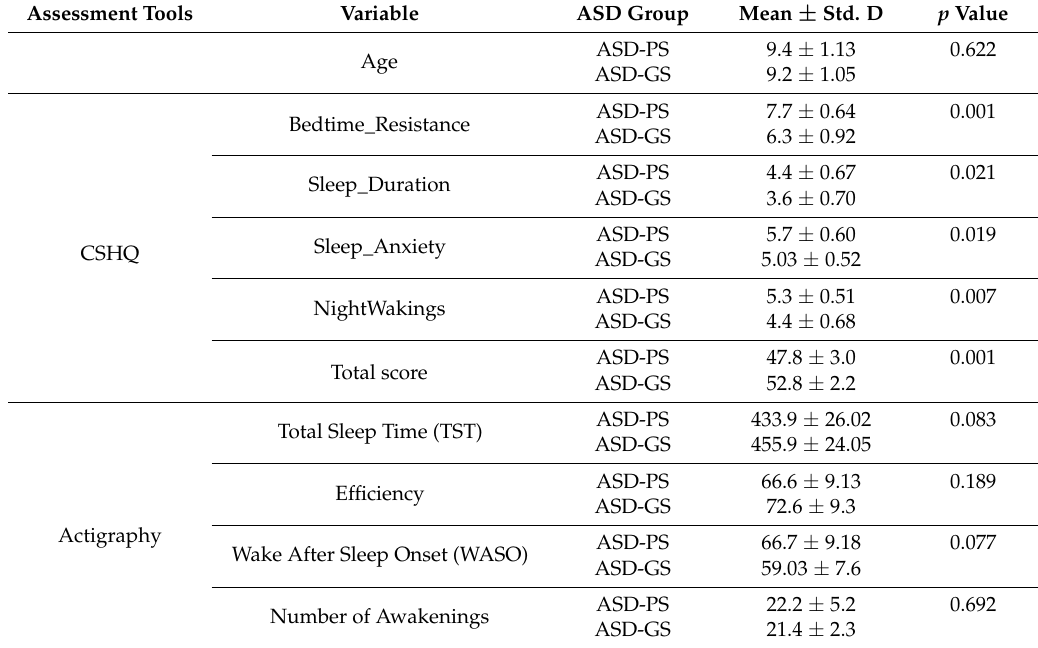
among autism spectrum disorder (ASD) Poor Sleepers (ASD-PS), ASD Good Sleepers (ASD-GS).